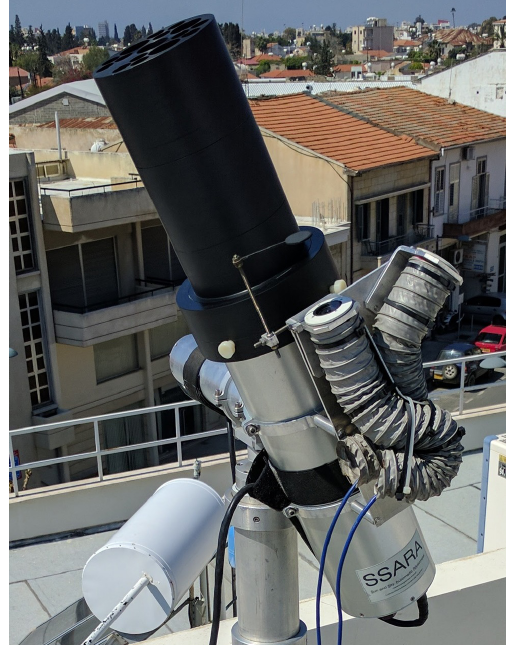
Figure 2. SSARA sensor head on the alt-azimuthal mount with straylight baffle